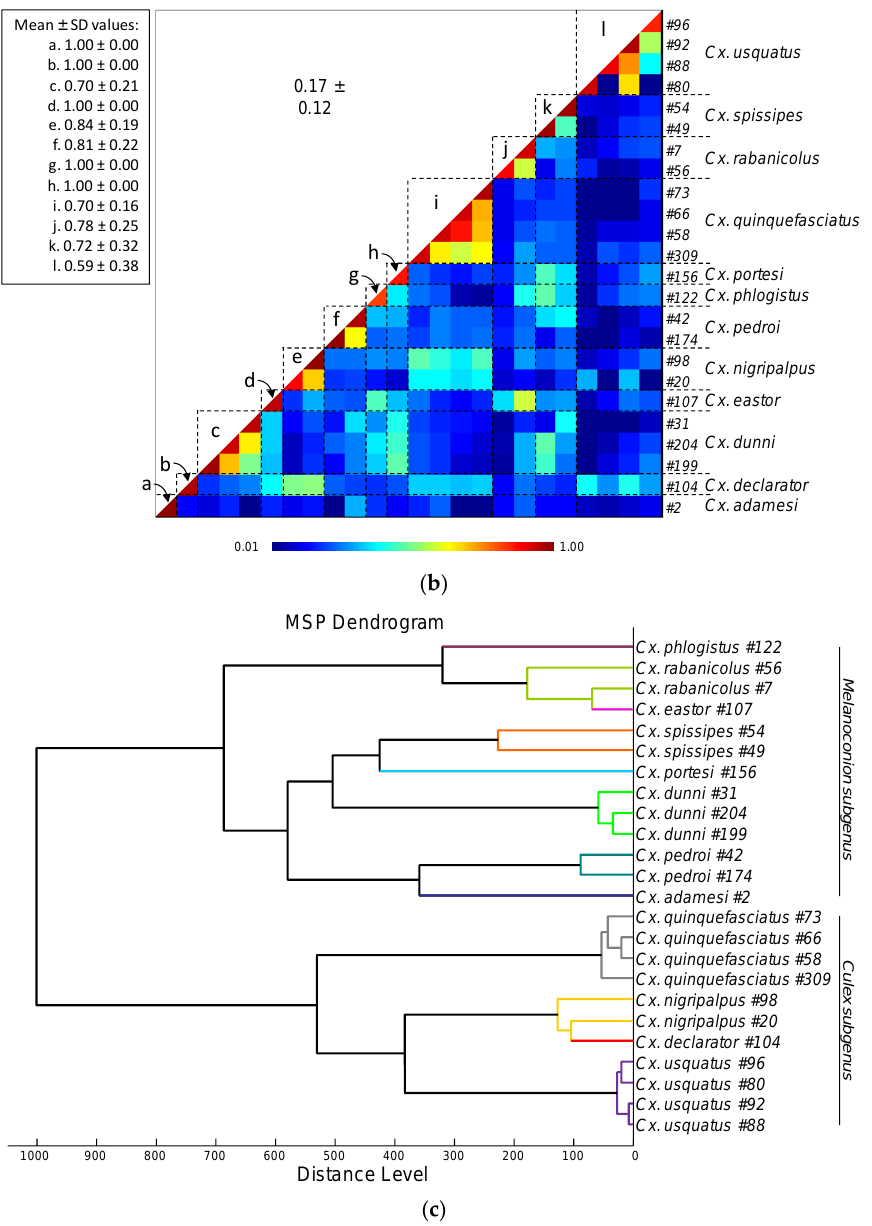
Figure 1. Comparison of MALDI-TOF MS spectra from legs of Culex mosquitoes. ( a ) Representative legs MS spectra of Culex species. The name of each species was indicated on the right corner of each spectrum. ( b ) Composite Correlation Index (CCI) matrix value representing the levels of legs MS spectra reproducibility among Culex specimens of the same species and between species. The 24 specimens from the 12 Culex species, which were selected as reference MS spectra introduced in the MS DB, are shown. The levels of MS spectra reproducibility are indicated in red and blue, revealing relatedness and incongruence between spectra, respectively. The values correspond to the mean coefficient correlation and respective standard deviations obtained for paired condition comparisons. CCI was calculated with MALDI-Biotyper v.3.0 software. ( c ) MSP dendrogram of MALDI-TOF MS spectra from legs of Culex mosquitoes from the 24 Culex specimens selected as reference MS spectra. The Culex and Melanoconion subgenera were indicated at the right. The distance units correspond to the relative similarity of MS spectra. The dendrogram was created by Biotyper v.3.0 software. The same color code was used for specimens of the same Culex species between panels ( a , c ). a.u., arbitrary units; Cx. , Culex ; MSP, Main Spectrum Profile; m/z, mass-to-charge ratio; SD, standard